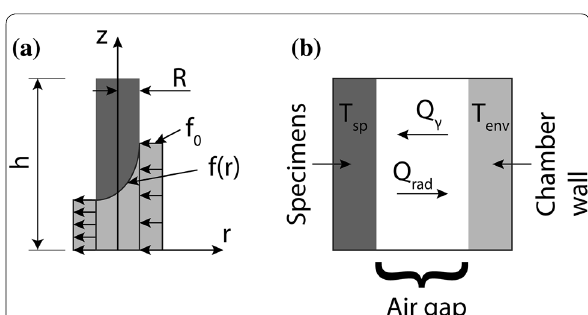
Fig. 2 Profile view of a the attenuation of the radial radiation field through the target specimen(s), and b the energy balance between the specimens and the